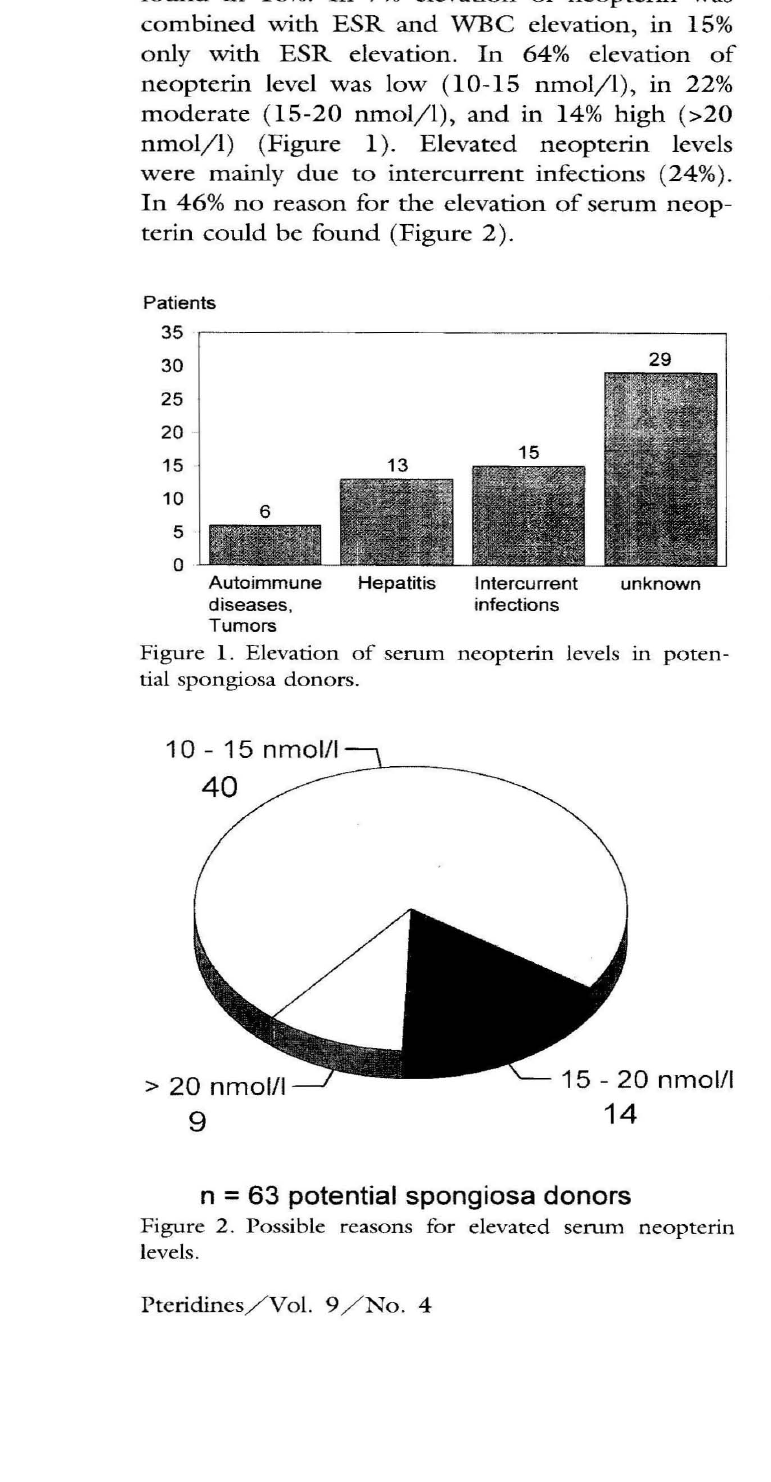
Figure 2. Possible reasons for elevated serum neopterin levels.